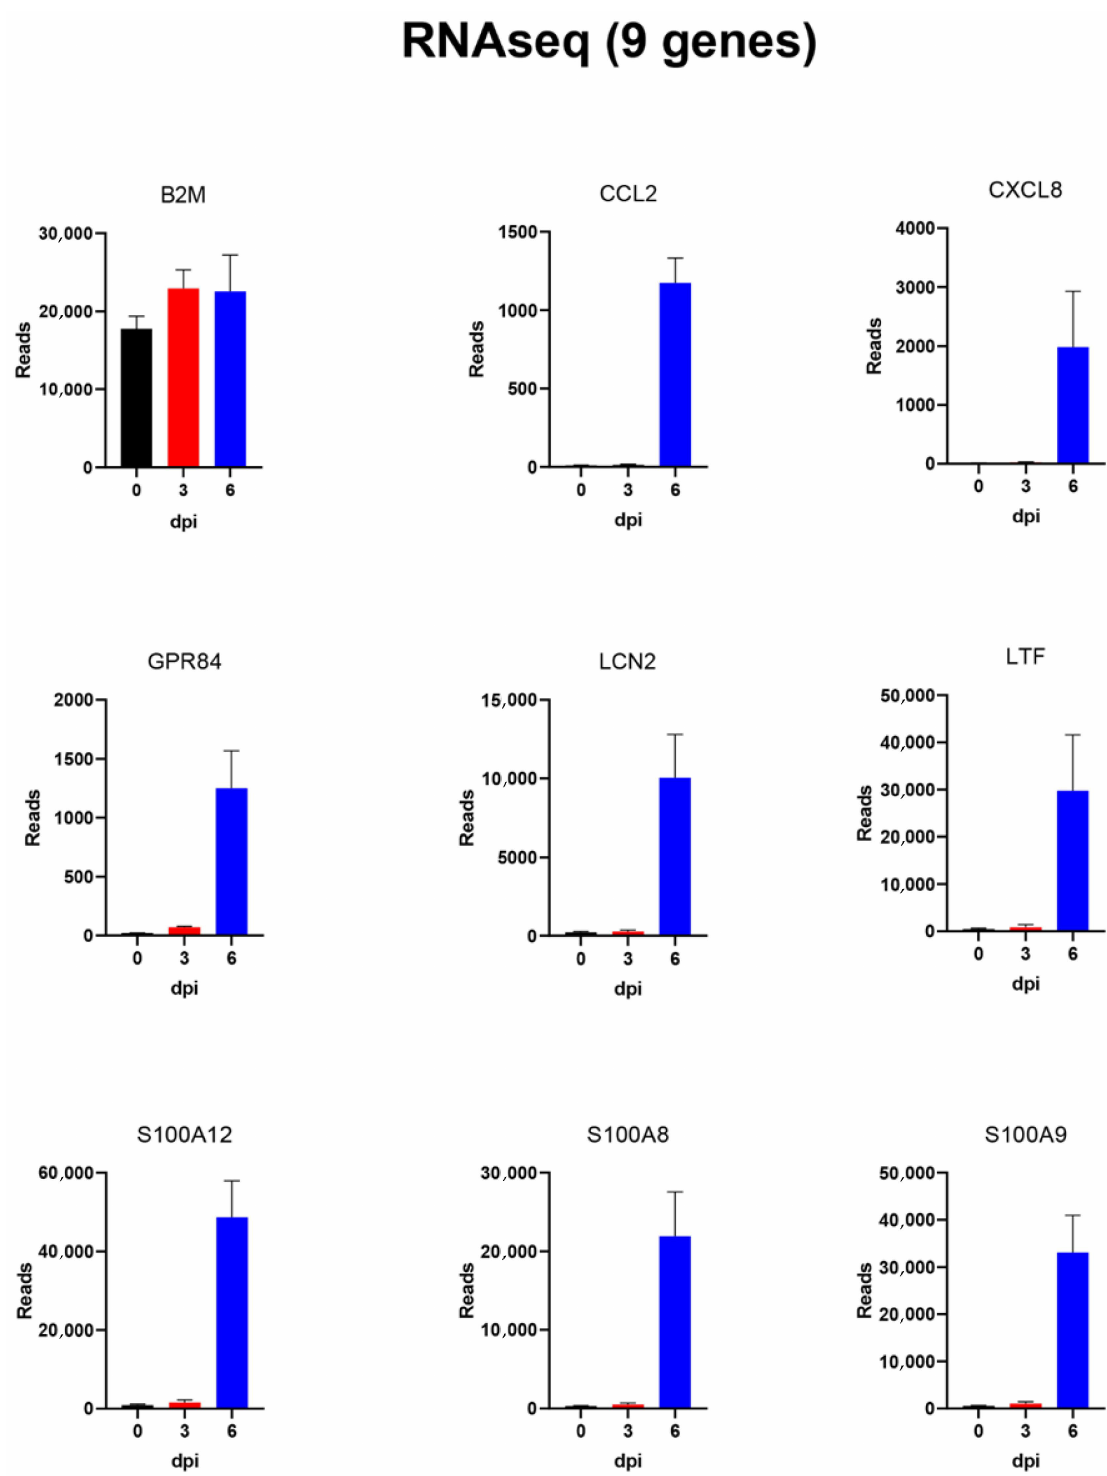
Figure 4. Expression of 9 selected host genes in PBMCs from ASFV-infected pigs as determined by RNAseq. The normalised numbers of gene sequence reads (mean + SEM for 4 pigs) for these selected genes are shown for the PBMCs collected at 0, 3 and 6 dpi. The expression of B2M was expected to be unchanged and acted as a reference gene. All of the other genes were expressed at >50–100-fold higher levels at 6 dpi compared to 0 dpi. There was little or no change in expression of these genes at 3